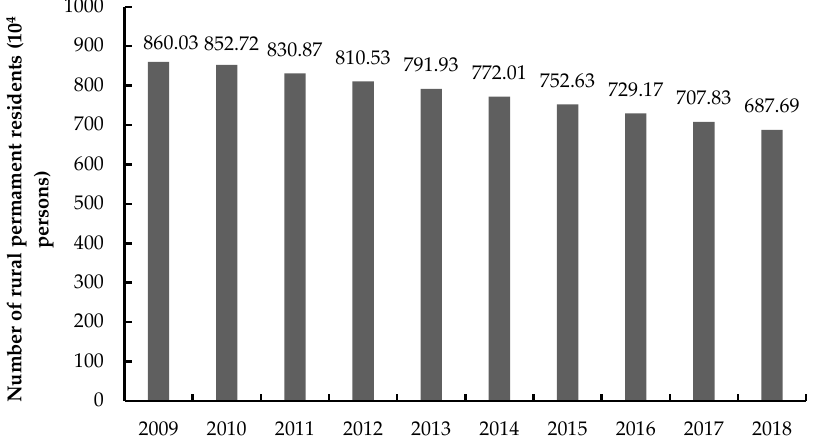
Figure 3. Changes of rural settlements land and arable land in the Yellow River Basin (Henan section) during 2009–2018.